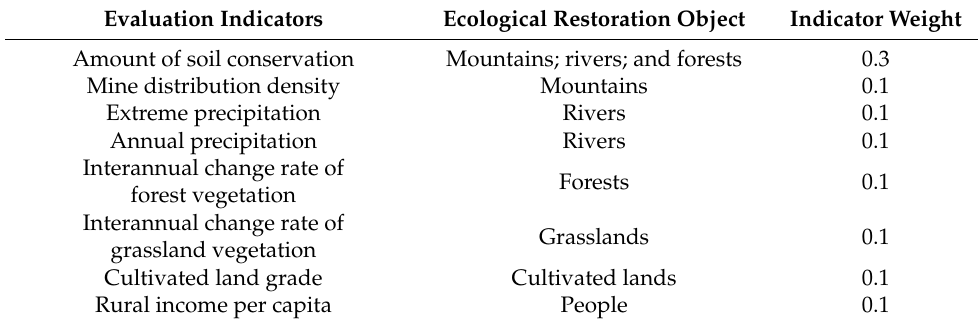
Table 2. Weight of the ecological restoration evaluation index in the Qilian